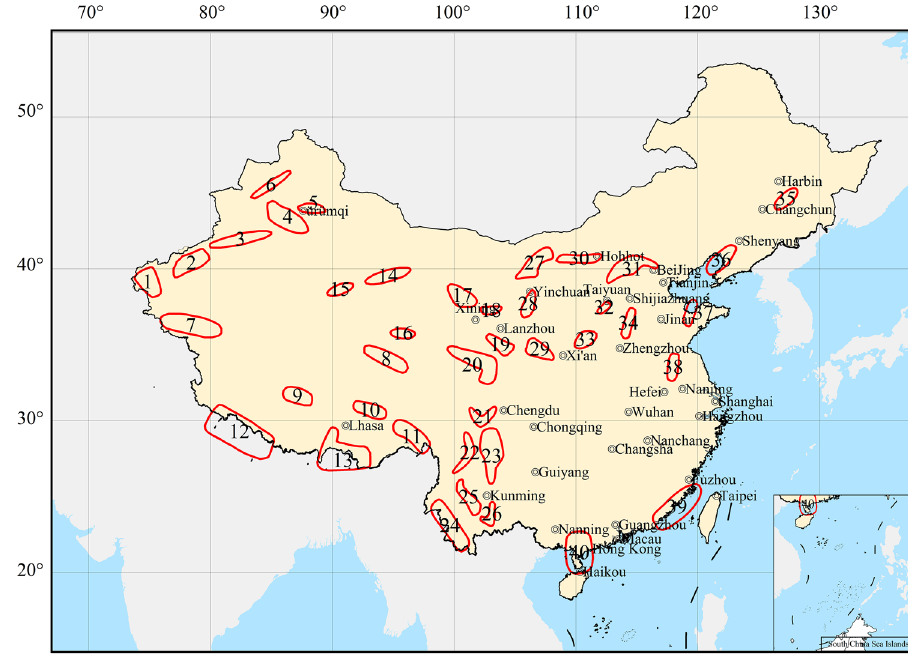
Fig. 4 Key seismic risk areas (encircled by red boundary) in China’s mainland. Source